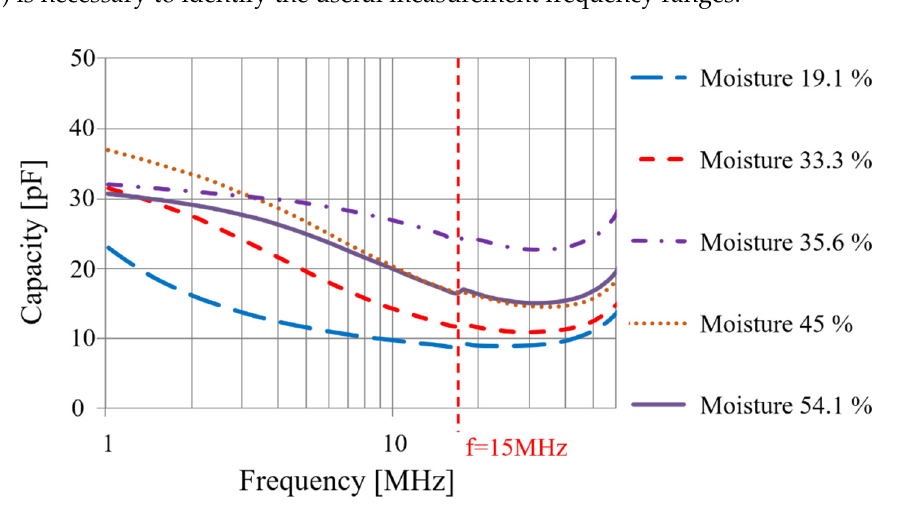
Figure 15. Measured capacitance as a function of the frequency.